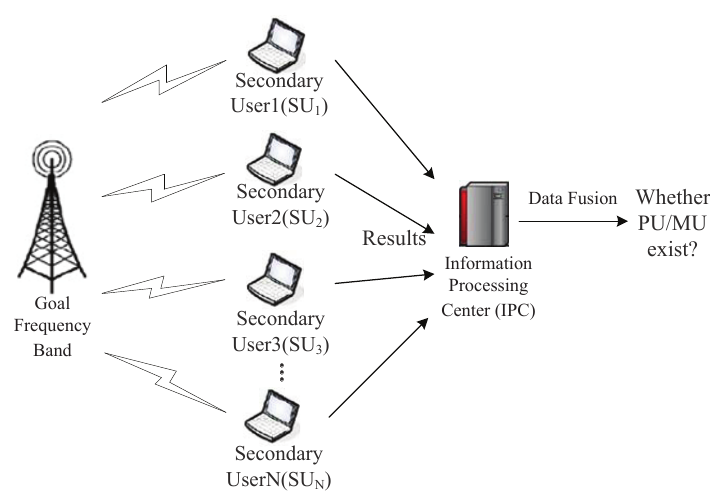
Figure 1. spectrum sensing model in cognitive radio